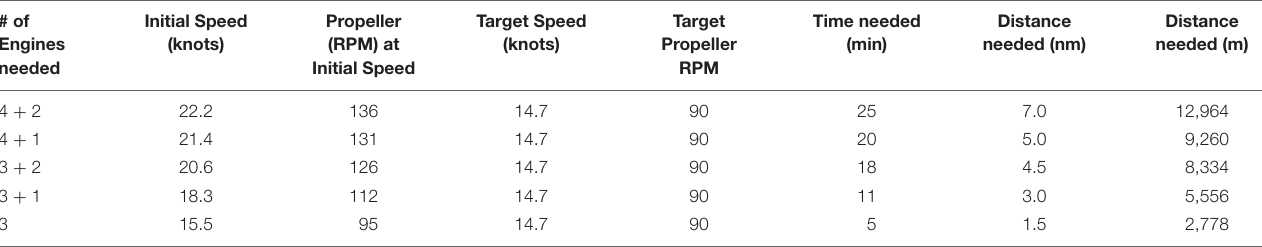
TABLE 1 | Approximate time (min) and distance (nautical miles) needed for slowing a large cruise ship with multiple engine configurations from various initial speeds to an (arbitrary) target speed of 14.7 knots using a safe slowing speed reduction of 2 RPM per minute. # of Engines needed